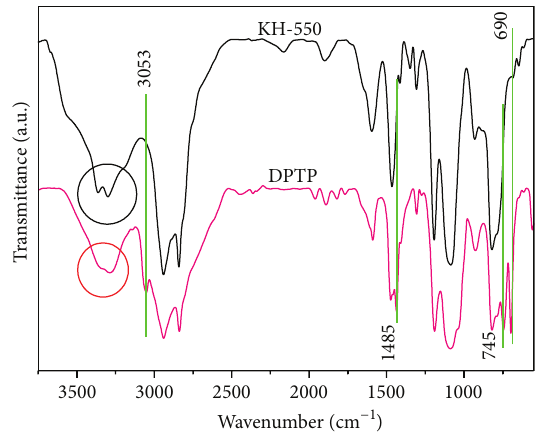
Figure 3: Compressive strength of